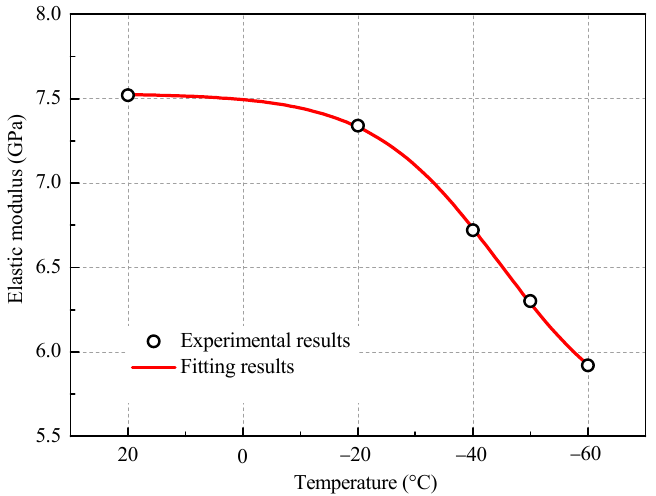
Figure 7. Variation of static elastic modulus with freezing temperature.